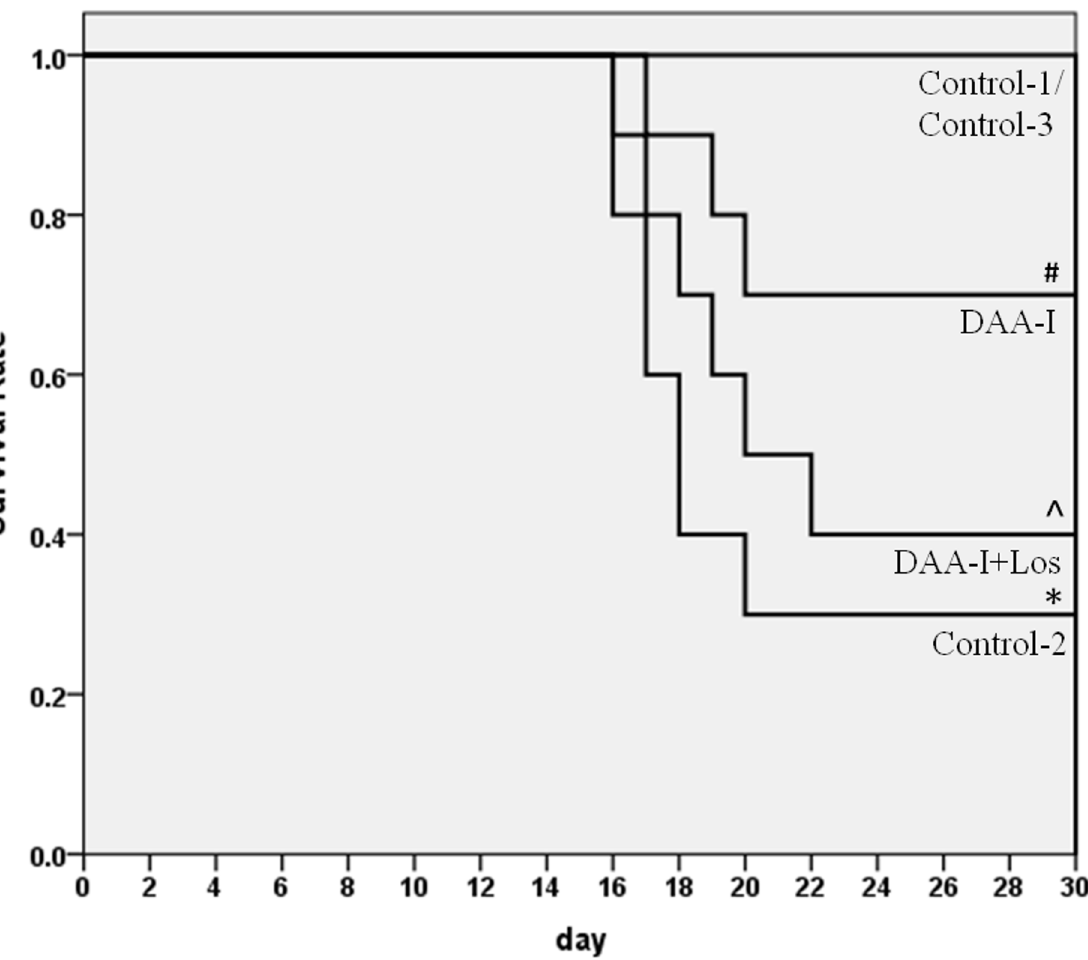
Fig 1. Kaplan-Meier curve of the effect of DAA-I and DAA-I plus losartan on the survival of mice exposed to 6.4Gy gamma irradiation. Animals were administered daily vehicle or drug/s on day 1 for a period of 30 days. Control-1: animals were administered 0.1 ml vehicle (water) and were not irradiated. Control-2: animals were administered vehicle and were irradiated. Control-3: animals were administered 800 nmole/kg DAA-I and were not irradiated. DAA-I: animals were administered 800 nmole/kg DAA-I and were irradiated. DAA-I + Los: animals administered 50 nmole/kg losartan and 800 nmole/kg DAA-I and were irradiated. * p < 0.05 vs Control-1. # p < 0.05 vs Control-2. ʌ p < 0.05 vs